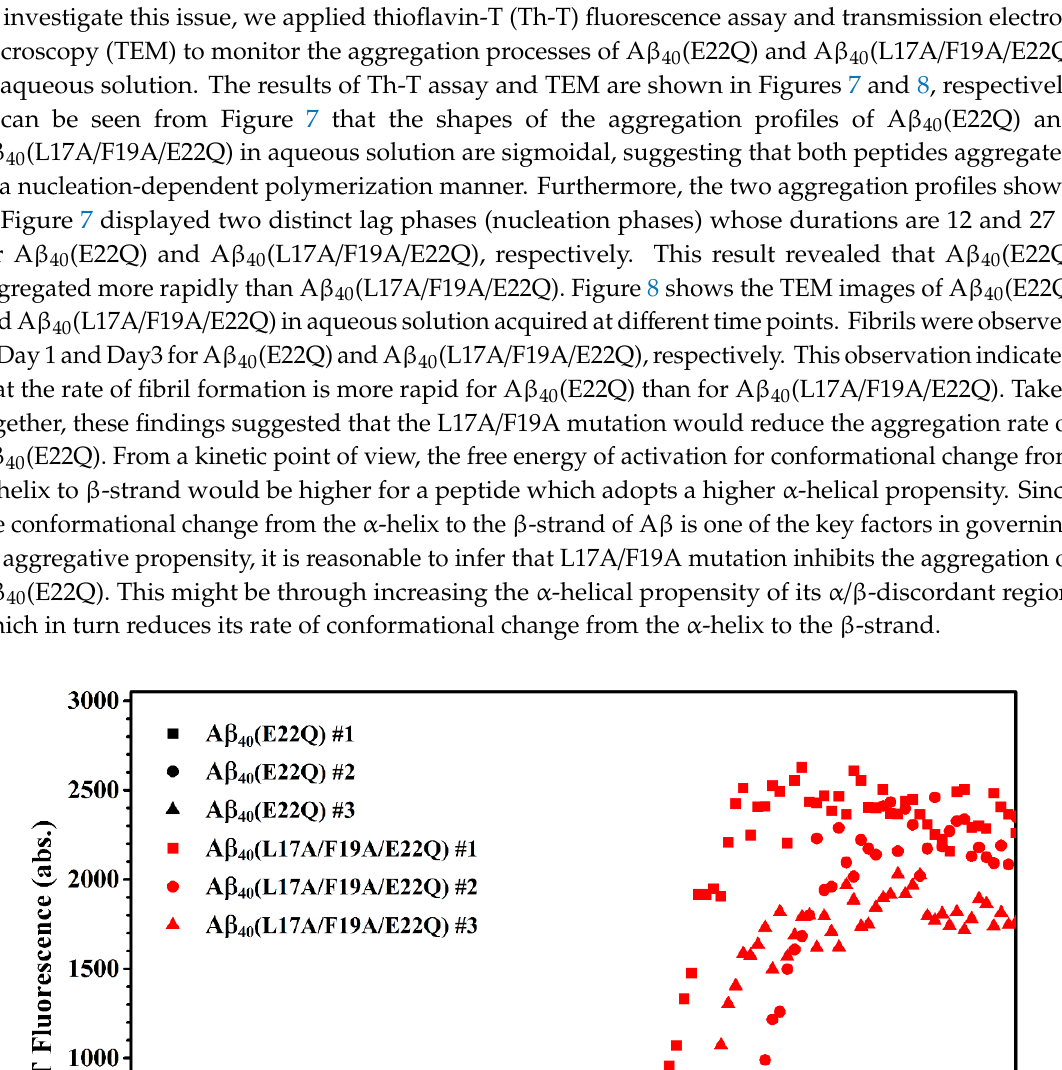
/ F19A / E22Q) β 40 (L17A